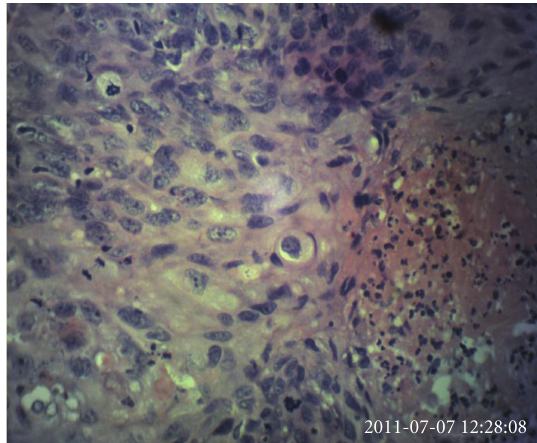
Figure 3: Photomicrograph of the breast lesion at higher power ( × 400). Section shows malignant squamous cells having large, highly pleomorphic vesicular to basophilic nuclei with conspicuous nucleoli. Many mitotic figures are seen on this field. Area showing suppurative necrosis is seen on the right lower corner. No keratin pearl is